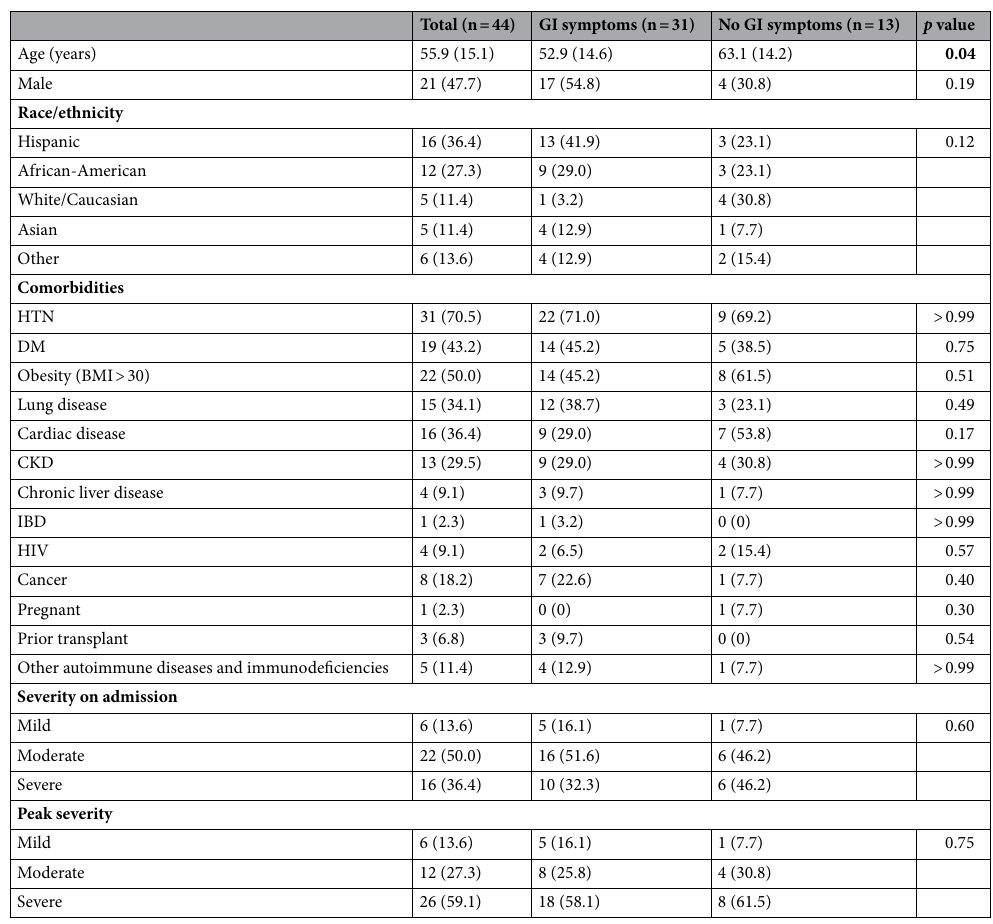
Table 1. Patient demographics and characteristics. The bold values indicate p -value < 0.05. The absolute number and percentage of the cohort (in parentheses) with each indicated characteristic. For Age, the median value (in years + / − the SD) is given. Statistical comparison of Ages is by Kruskal Wallis test and for other data by Fisher’s exact test.